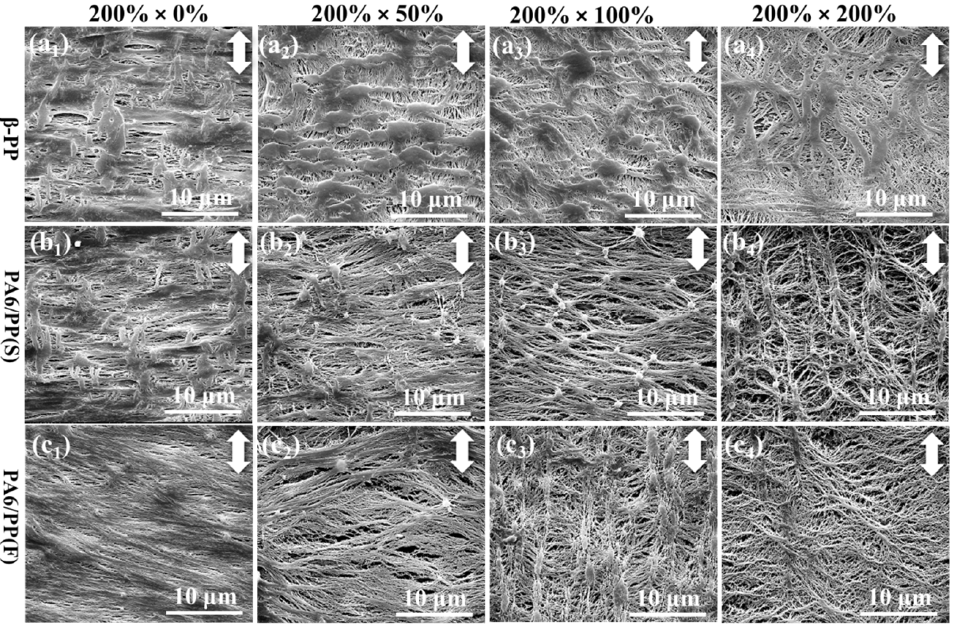
Figure 9. SEM images of the surface microporous structure of ( a ) β -PP, ( b ) PA6/PP(S) and ( c ) PA6/PP(F) during transverse stretching at 125 °C: ( a1 , b1 , c1 ) 200% × 0%, ( a2 , b2 , c2 ) 200% × 50%, ( a3 , b3 , c3 ) 200% × 100%, ( a4 , b4 , c4 ) 200% × 200%. The white double arrow represents the direction of stretching.